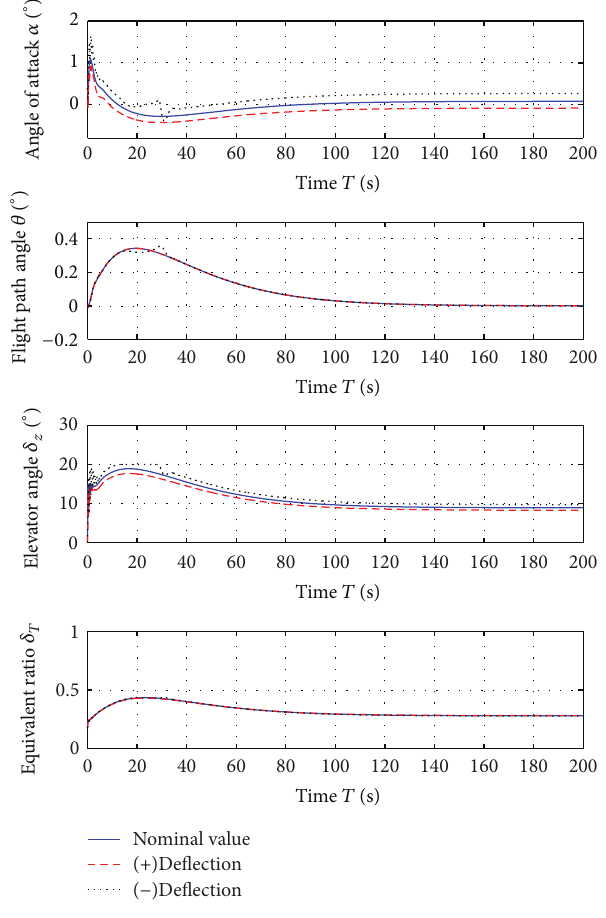
Figure 3: Attitude response